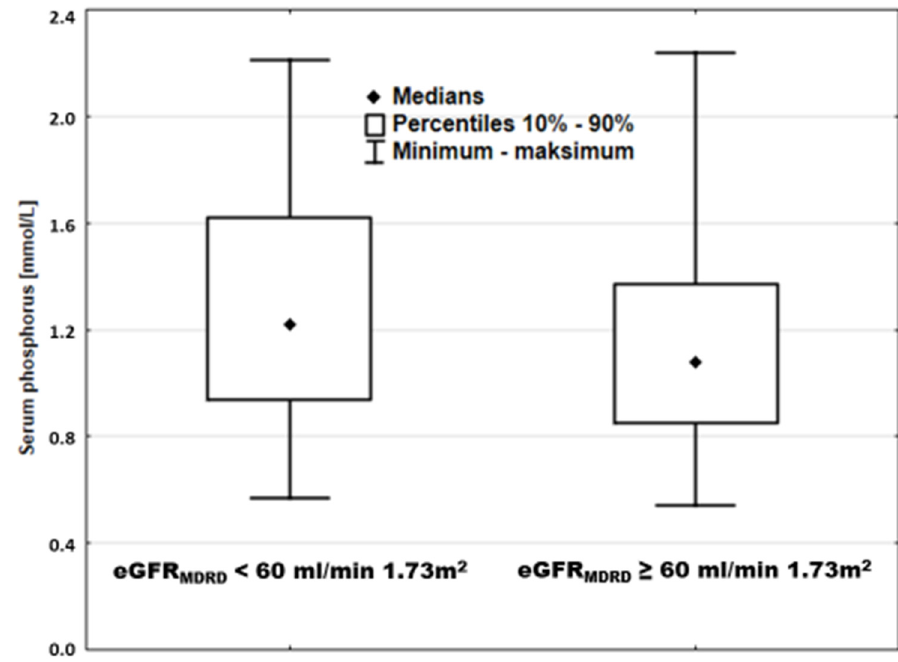
Figure 7. Serum phosphorus in patients stratified according to kidney function.